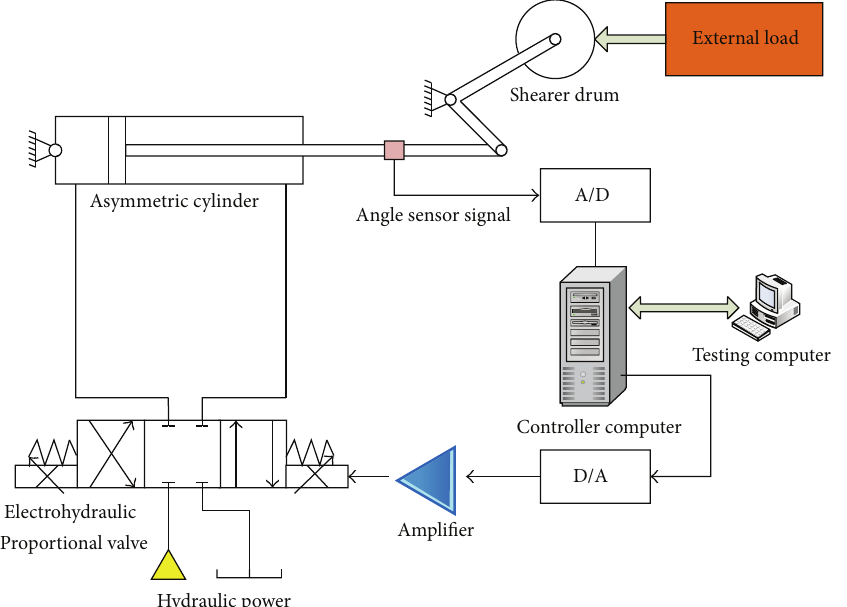
Figure 6: Testing principle of the experimental system.